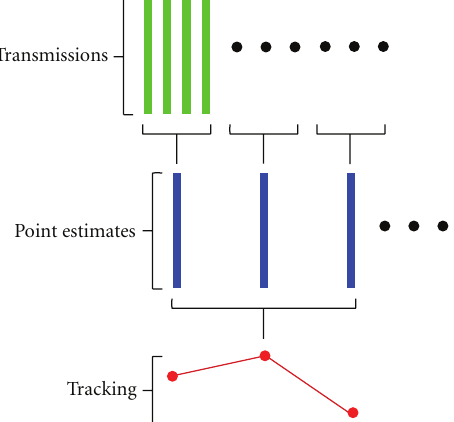
Figure 2: One round of surface buoy broadcasting leads to one point estimate, while tracking algorithms improve the localization accuracy when multiple-point estimates are